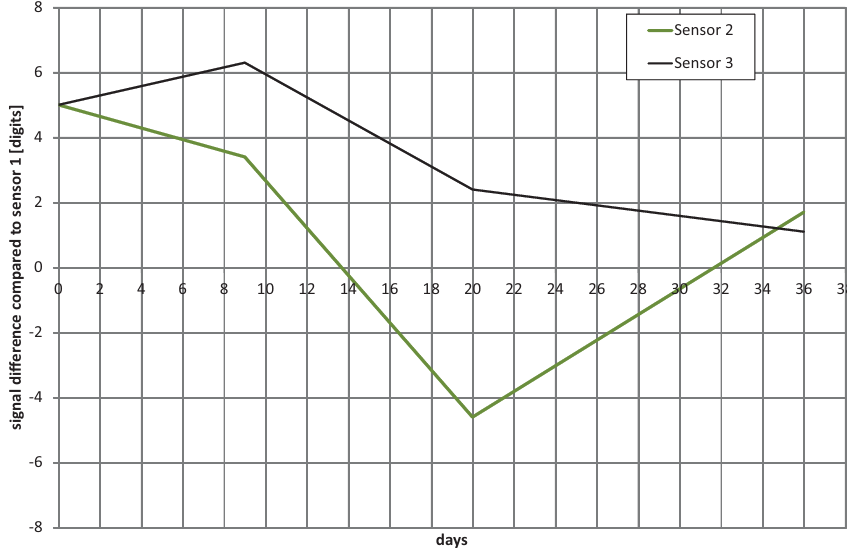
Figure 4. Relative differences between three VOC sensors over a period of 5 weeks.